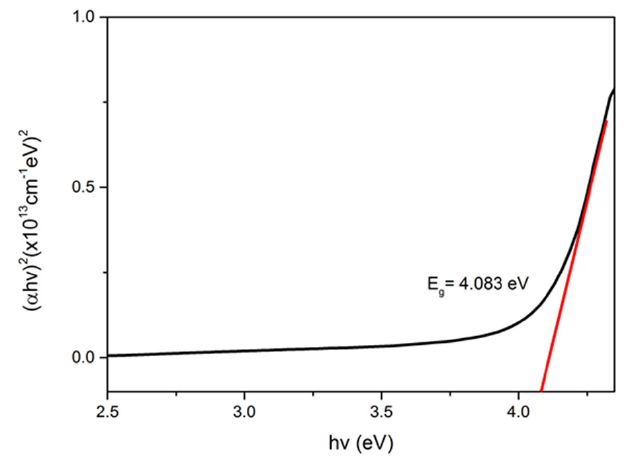
Figure 7. Optical band gap of GO–PVA thin film.